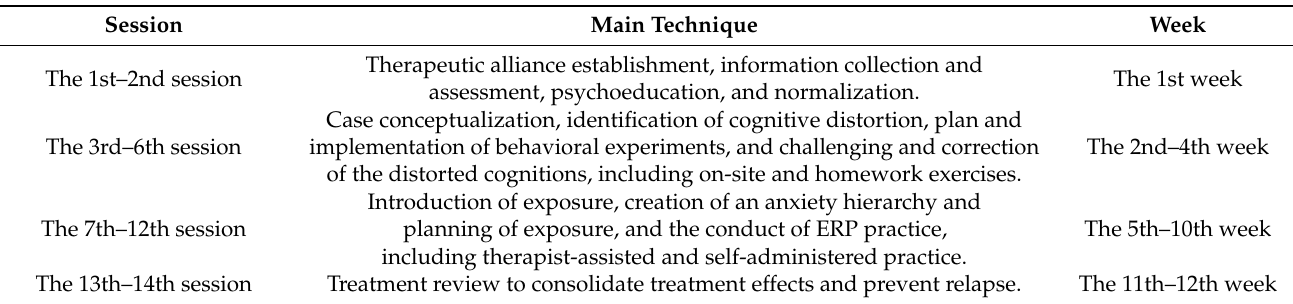
Table 1. The overview of the 14 CBT